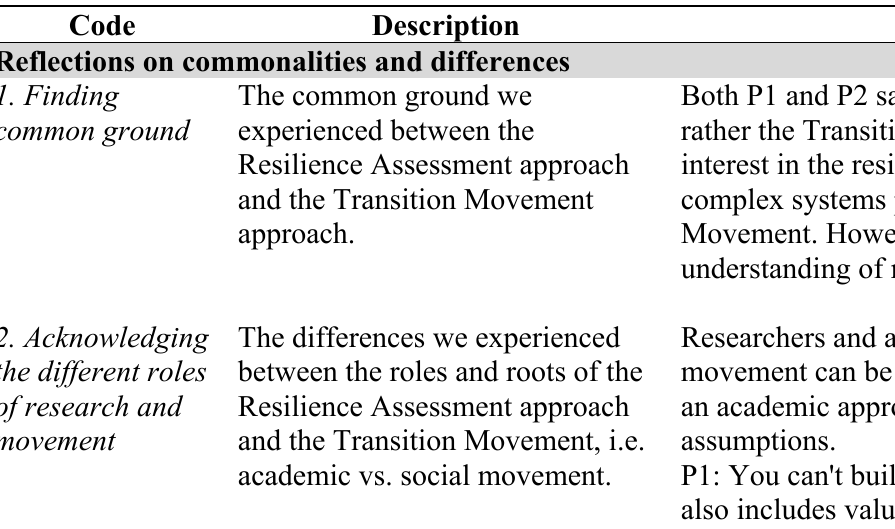
Table A5.1. Description and synthesized results for each of the focused codes